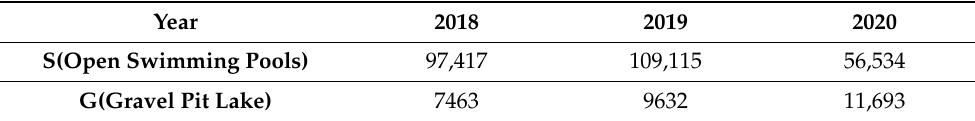
Table 1. Number of ticketed entries to the municipal bathing areas